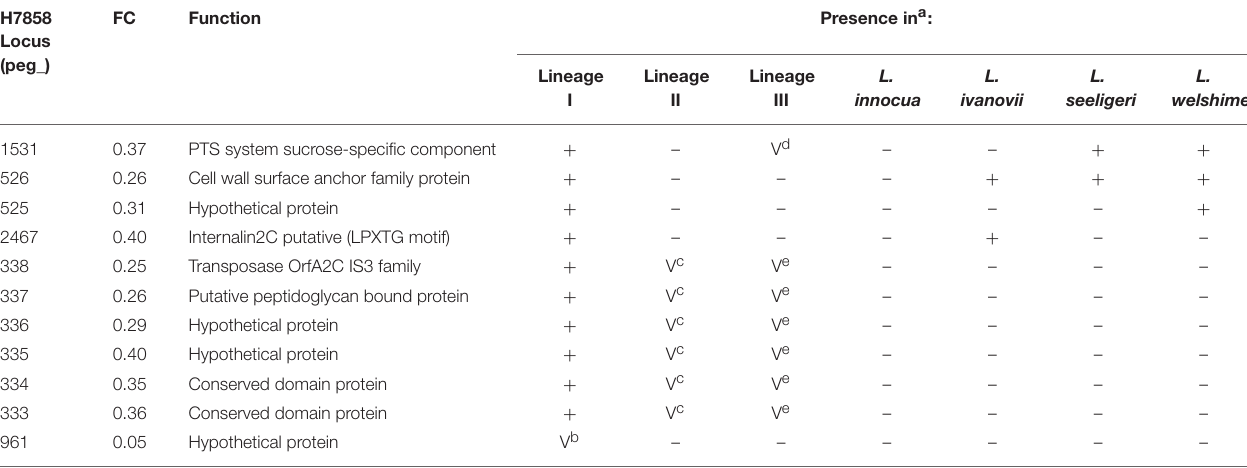
TABLE 4 | Genes downregulated by bile in H7858 with no homolog in 10403S. H7858 Locus